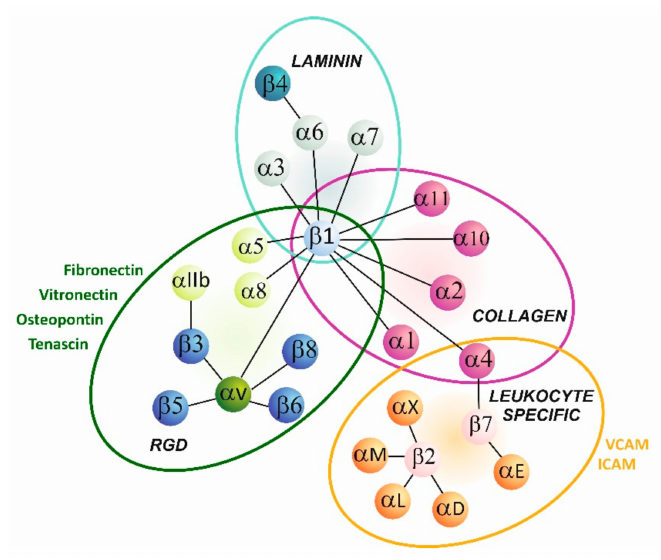
Figure 1. Overview of main integrin heterodimers and their